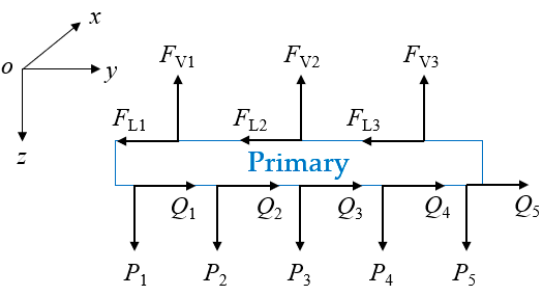
Figure 6. Force analysis of the primary winding.